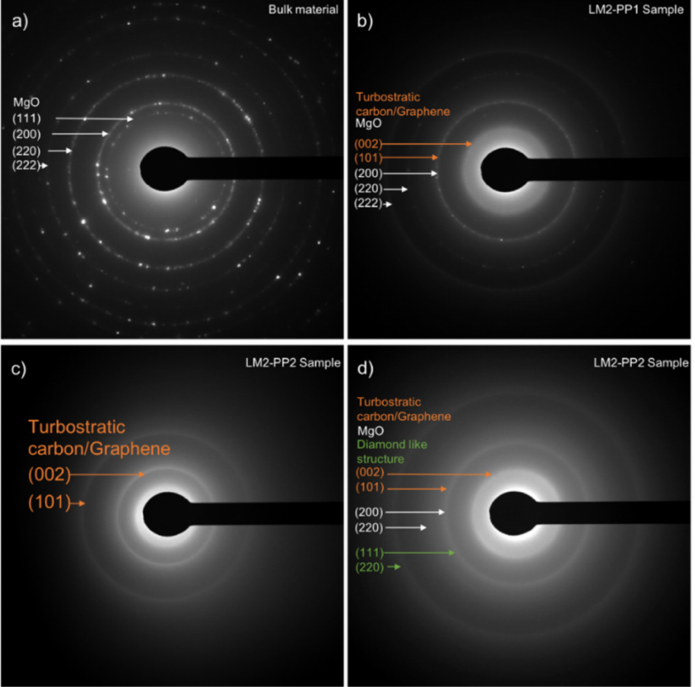
Figure 6. SAED patterns of ( a ) bulk material, ( b ) LM2-PP1 sample, ( c ) and ( d ) LM2-PP2 sample analyzed in different